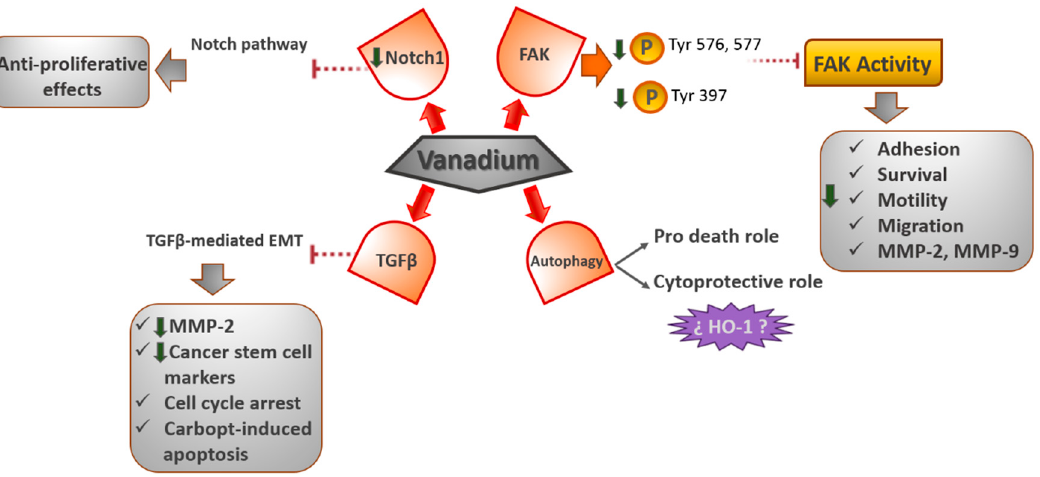
Figure 4. Downregulated proteins involved in survival and cell death induced by vanadium com ‐ plexes.